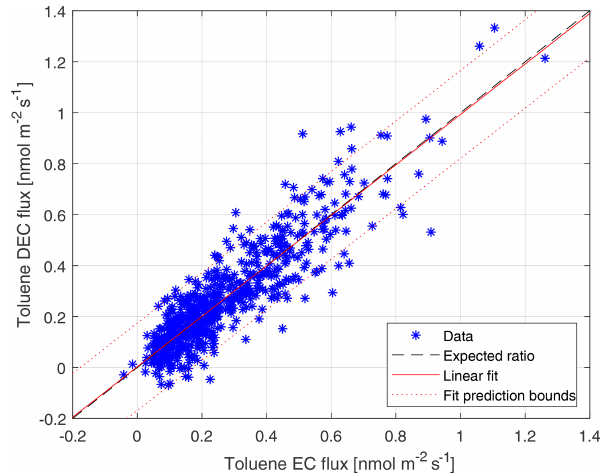
Figure 3. Toluene flux determined by DEC (taking every 50th sam- ple) vs. toluene flux determined by EC. The fitted curve shows very good correspondence between the DEC and EC flux results, with slope close to 1 (slope: 0.99; offset: 0.003; R 2 : 0.89).